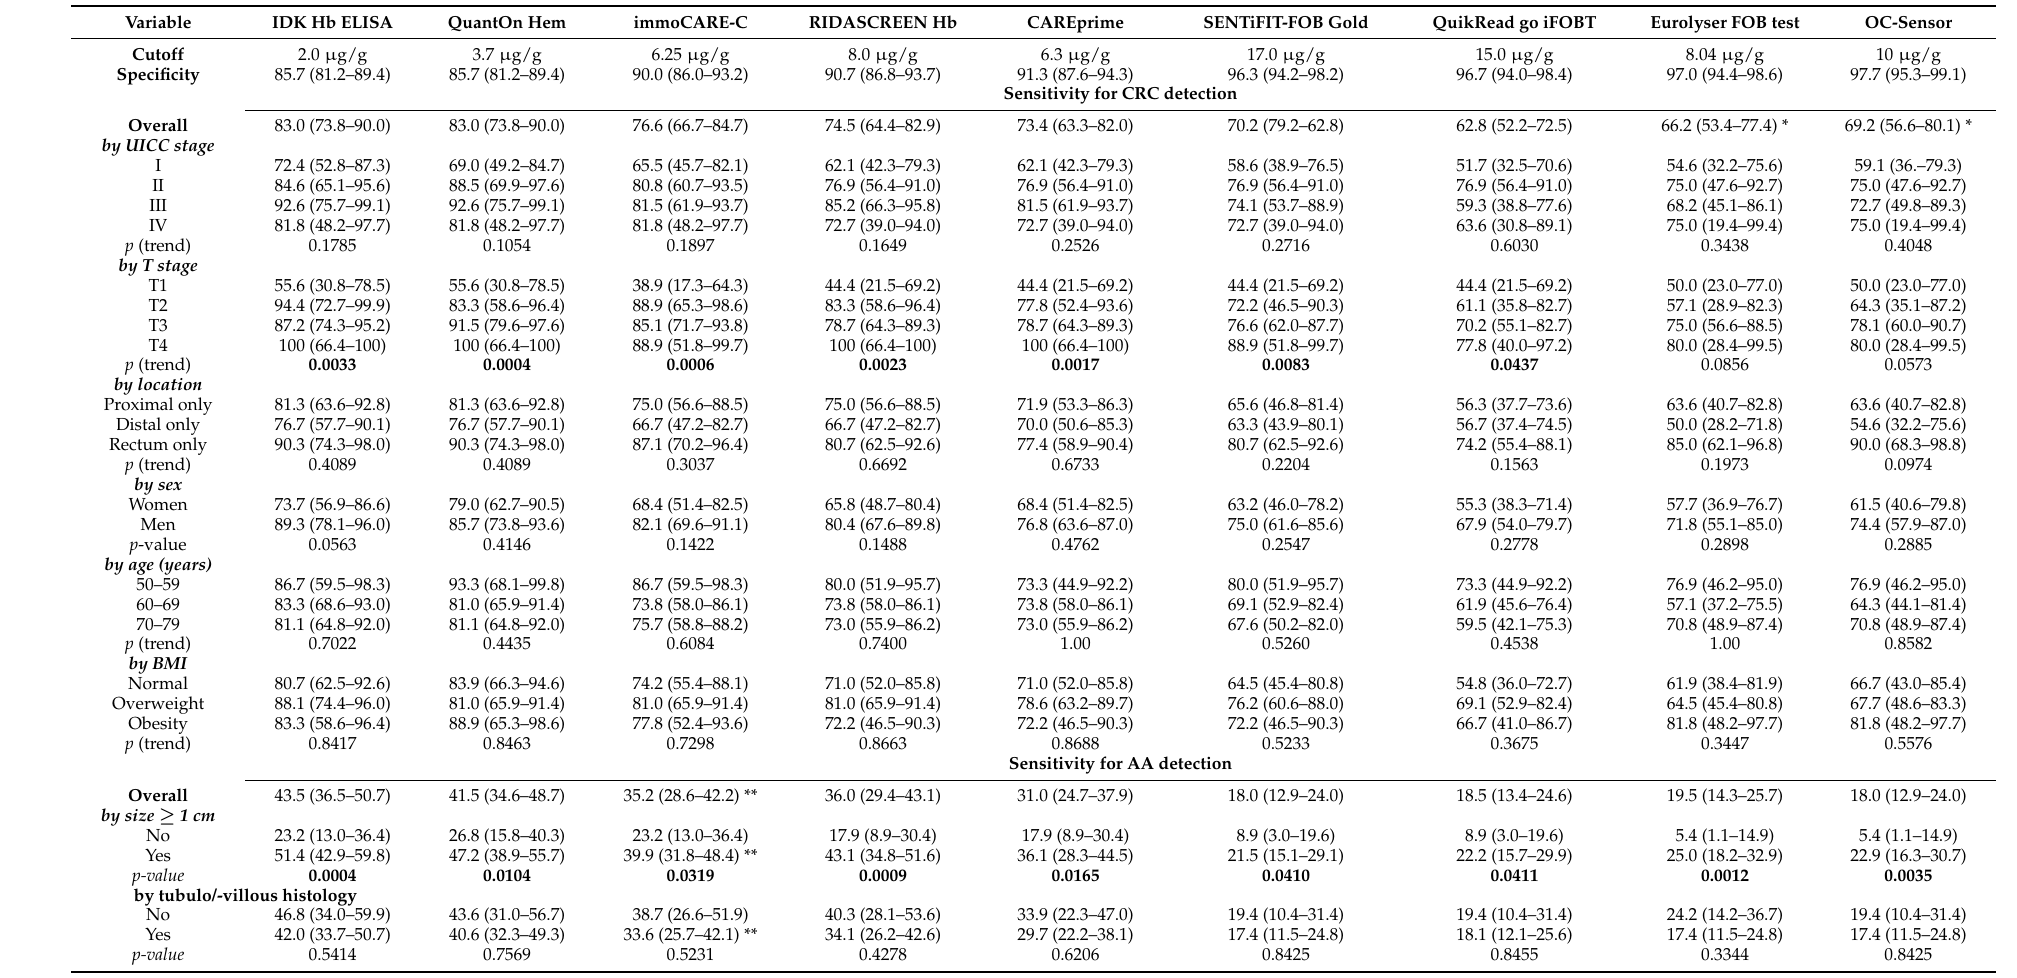
Table 3. Sensitivity (% (95%CI)) at original